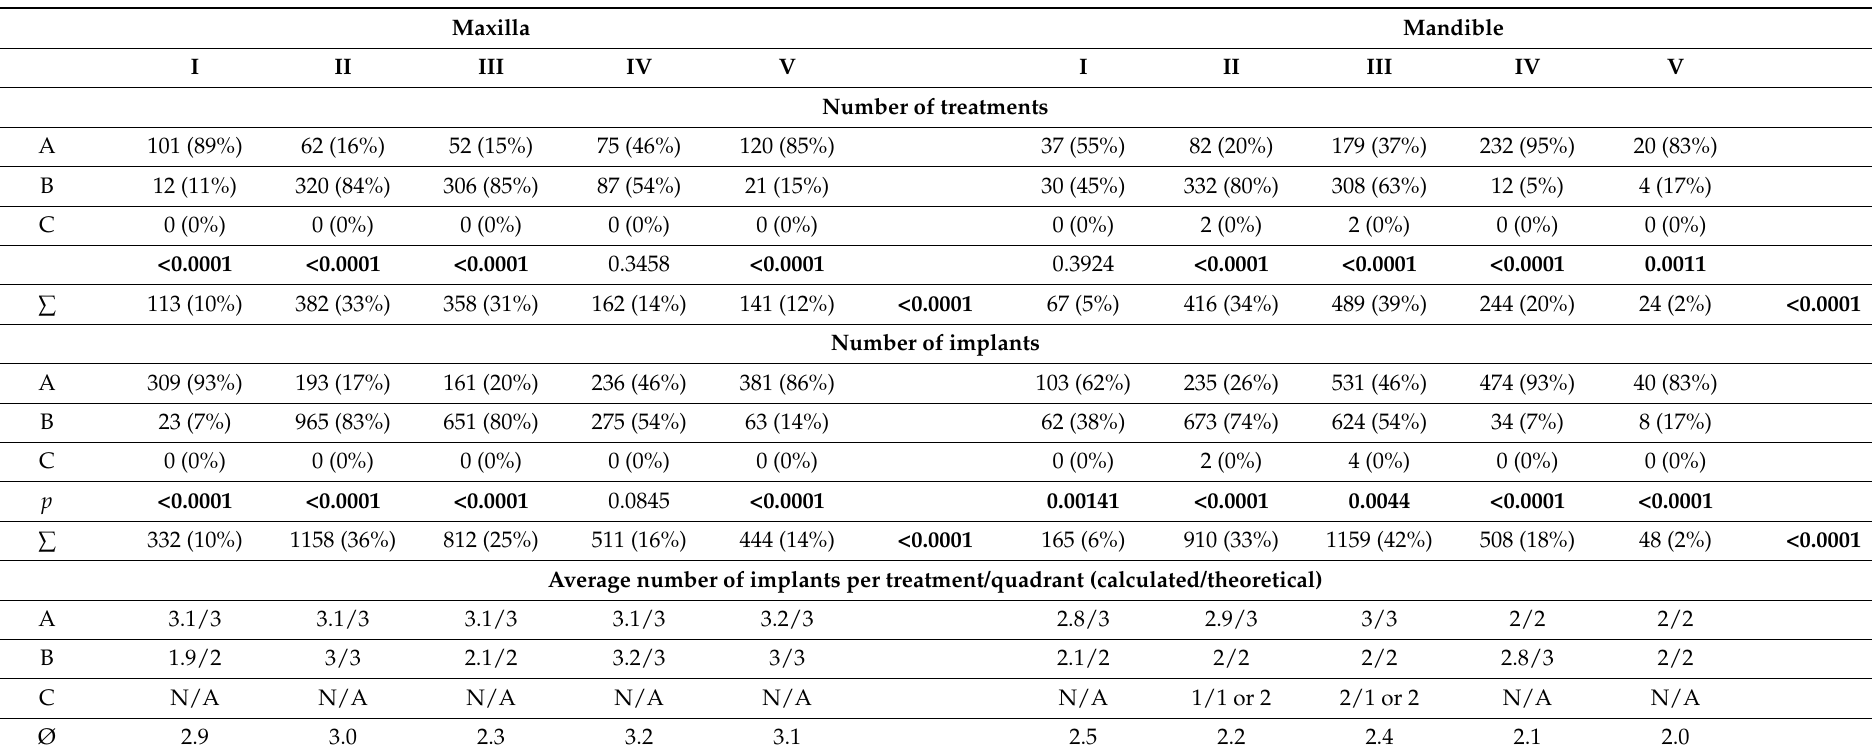
Table 4. Descriptive statistics of study variables stratified by CCs and TOs of the CDSS. Number of treatments ( n = 2596 treatment units) and number of implants ( n = 6047) are reported as the total number and percentages relative to individual CCs. Follow-up times are reported at the implant level as the average values and SD. Gender (ratio of female and male patients), patient age (average values and SDs), the number of systemic conditions (average values and SDs) and smoking habits (total number of smokers and relative percentages of smokers in the TC) are reported at the treatment level. Bracketed % values reported at the TO level refer to the % relative to the individual CCs. Bracketed % values reported at the CC levels refer to the % relative to the total value on the maxillary or mandibular level; p -values related to differences at the TO and CC level were obtained using Fisher’s exact test; p -values indicating statistical significance are marked in bold. Abbreviations: SD, standard